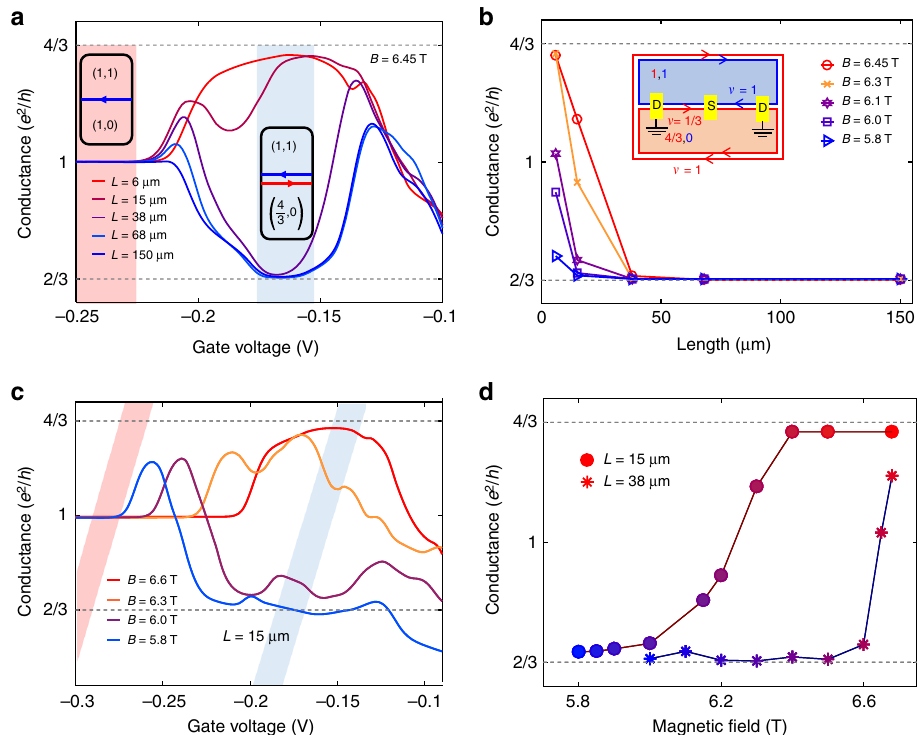
Fig. 3 Length and magnetic fi eld dependent two-terminal conductance. a Two-terminal conductance versus center top-gate voltage for different propagating lengths at B = 6.45 T. The upper region is set to (1,1), and the center region is tuned in the ranges of gate voltage highlighted by red and blue areas,tuned to (1,0) and (4/3,0), respectively. In the blue area, a v = 1 and a v = 1/3 counterpropagating chiral modes coexist at the interface, and the conductance decreases from G 2T = 4 e 2 /3 h to 2 e 2 /3 h as the channel length increases from 6 µ m to 150 µ m. In red area, the conductance is e 2 / h and is length independent due to a single a v = 1 chiral mode at the interface. b Two-terminal conductance versus propagating length at different magnetic fi elds, with the center region is tuned to (4/3,0). c Two-terminal conductance of a 15 - μ m long channel as a function of center gate voltage in a range in magnetic fi eld 5.8 T < B < 6.6 T. The colored areas are as in panel c . d The dependence of the two-terminal conductance on the magnetic fi eld for propagating length L = 38 µ m and 15 µ m. With decreasing the magnetic fi eld, the two-terminal conductance evolves from G = 4 e 2 /3 h to 2 e 2 /3 2T